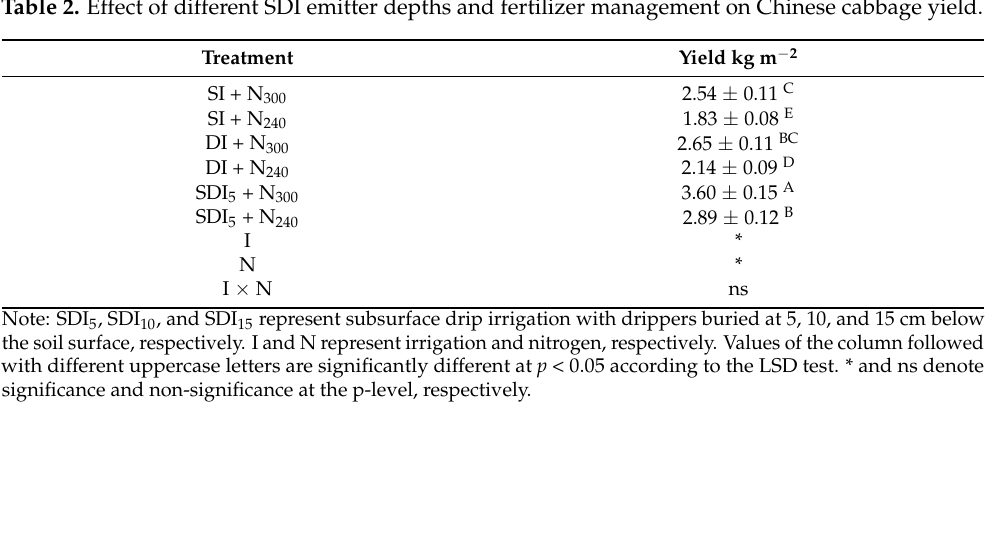
Table 2. Effect of different SDI emitter depths and fertilizer management on Chinese cabbage